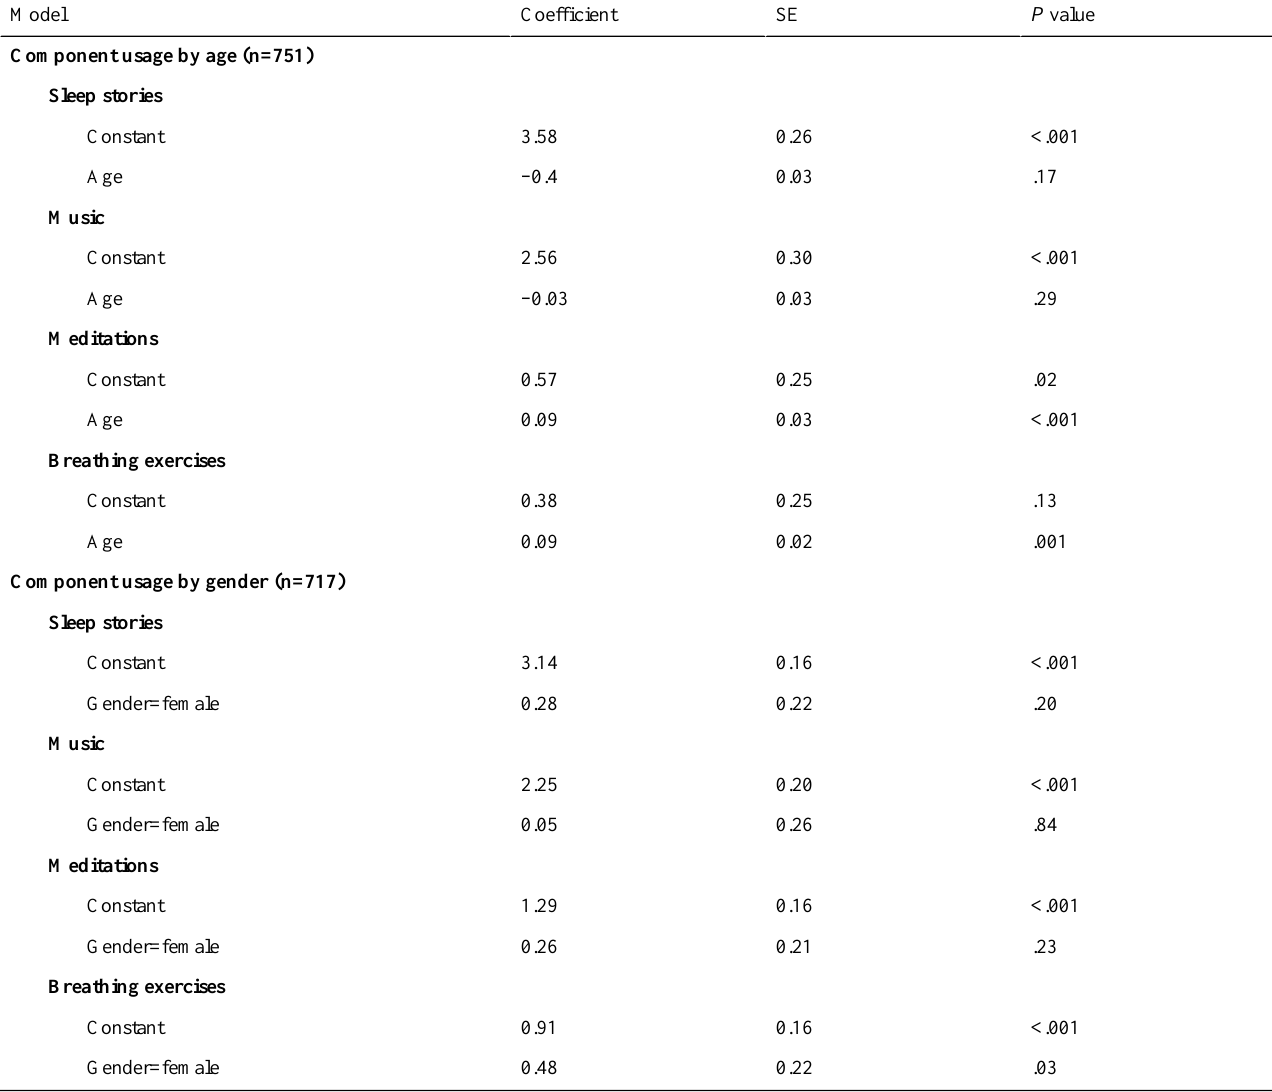
Table 3. Frequency of component usage by age and gender. a